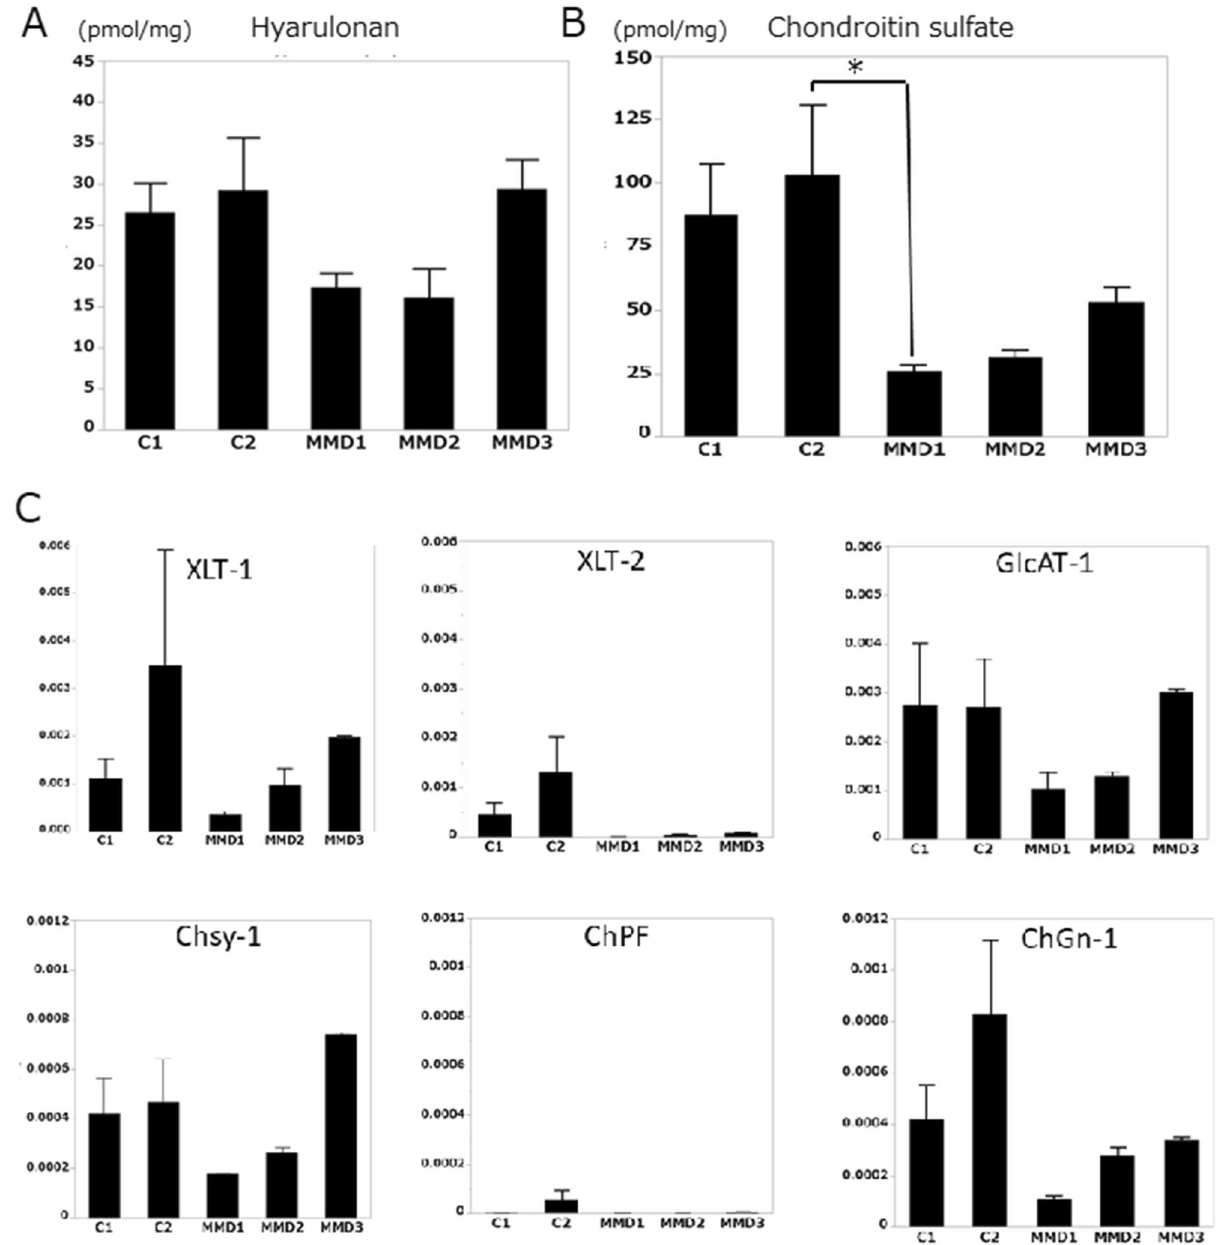
Figure 4. ( A ) The amount of HA in each iPSEC sample. ( B ) The amount of CS produced by each iPSEC sample. MMD1 produced significantly smaller amounts of CS compared with Control 2 (* P < 0.05). ( C ) Expression of enzymes for CS synthesis. Although there was no statistical significance, XLT-2 tended to be downregulated in MMD. XLT, xylose transferase; GlcAT-I, glucuronosyltransferase-I; ChSy-1, chondroitin synthase-1; ChPF, chondroitin polymerizing factor; ChGn, chondroitin β1,4- N -acetylgalactosaminyltransferase. Error bars are Figure 7C compares the WSS distribution (left panel) and stream lines (right panel) in model A. The view angle is the same as in the left view of Fig. 7A. The color of each stream line represents the magnitude of flow velocity. In the right panel of Fig. 7C, blood flowing at high speed is observed near the arterial wall. Such high speed flow is responsible for the high WSS near the ICA terminal bifurcation, because the locations of the high speed flow correspond to the wall surface regions on which high WSS is exerted. This characteristic flow structure was not found near the CCA terminal bifurcation in model B presumably because of the mild branching angle and the bulging shape of the carotid sinus. The observations of the present simulation suggest that the terminal of the ICA, the most frequent site for stenosis in MMD, is subject to high WSS.